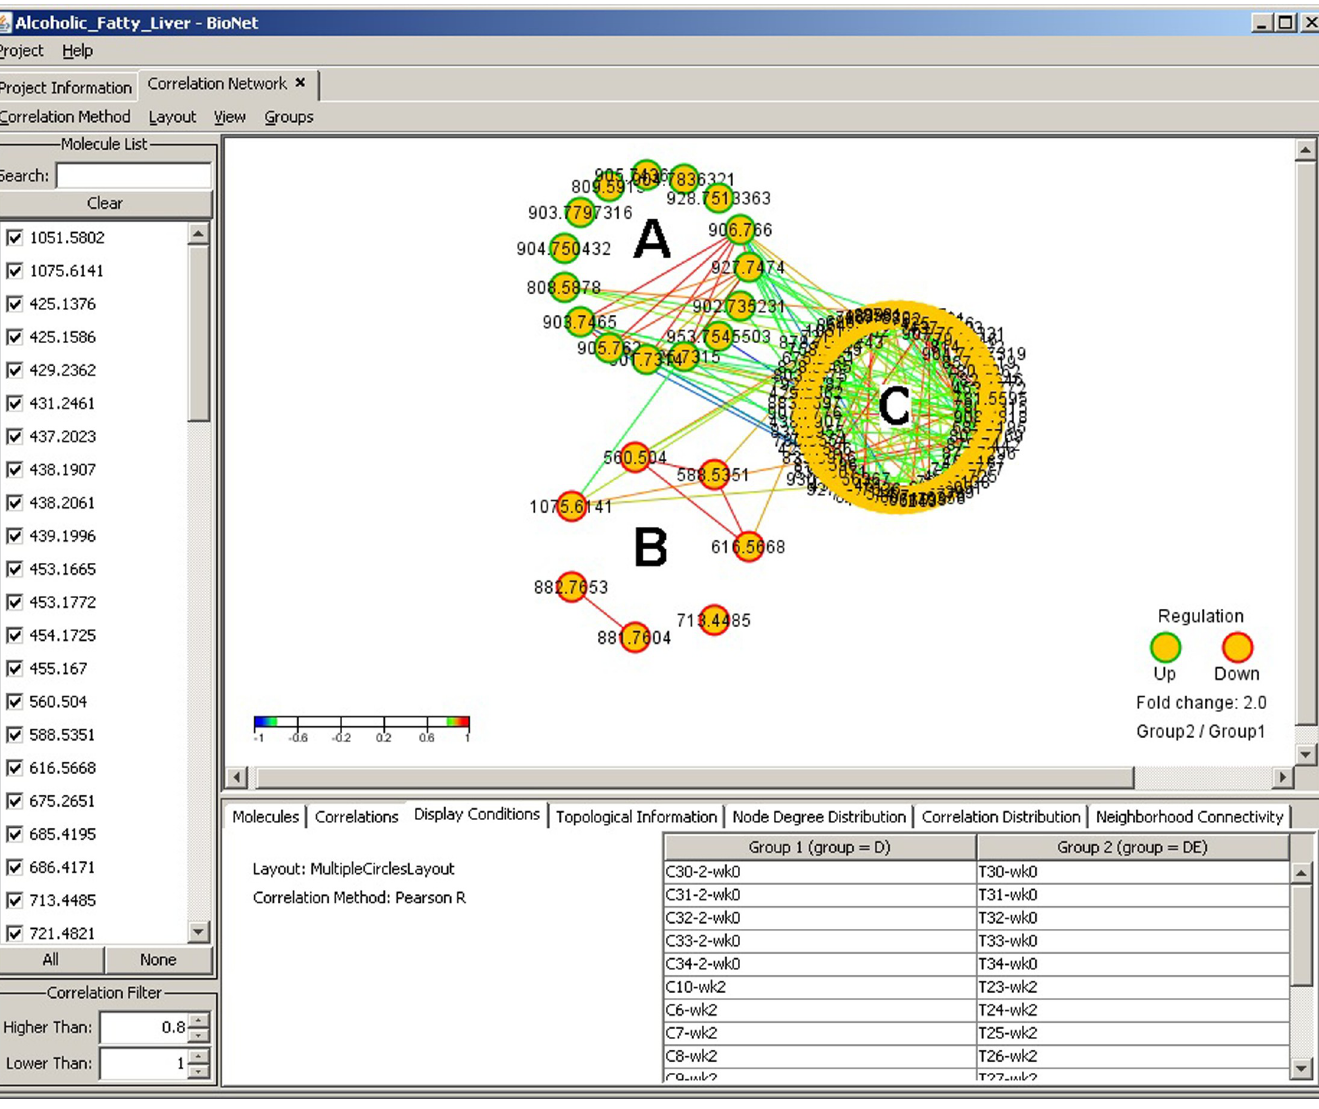
Fig 3. Correlation analysis window with multiple circle layout. Three-circle network graph display illustrating the up-regulated molecules in green borer nodes(A), down-regulated in red border (B), and other (not differentially expressed) molecules with no border (C). The fold change threshold is set at 2, meaning that molecules regulation that don’t meet this threshold are grouped in the third neutral circle (C). The fold change value can be adjusted